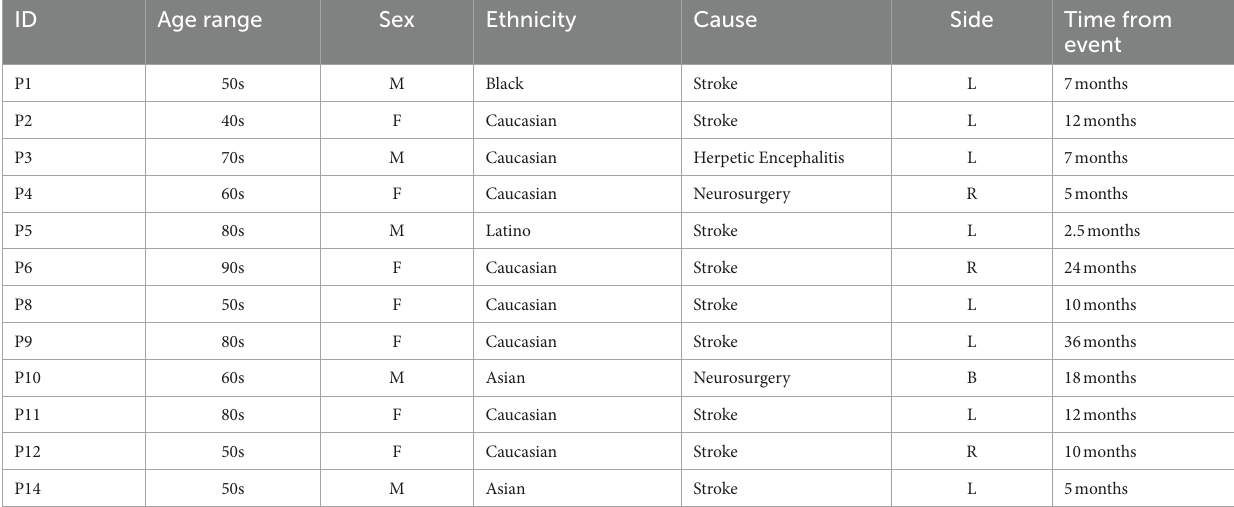
TABLE 1 Participants’